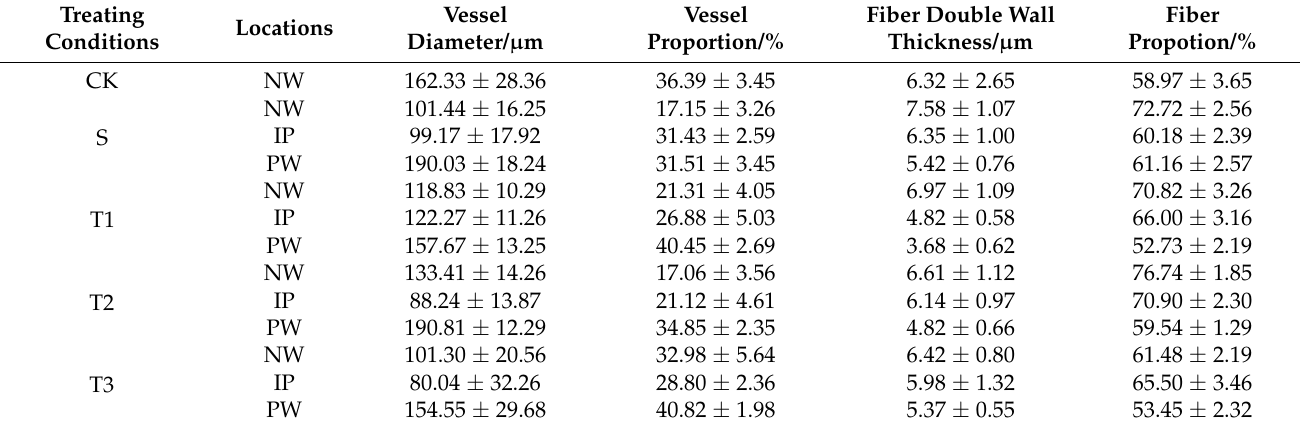
Table 1. Vessel diameter, vessel proportion, fiber proportion and fiber double wall thickness in different positions of poplar under different treatment conditions. The values after the +/ − sign represent the standard deviation: T1, T2 and T3 for the 110,100 mmol/L TEOS modification treatment group, S for the SiO 2 colloidal injection group, CK for the unmodified treatment group, PW for the previously grown wood, IP for the injection point and NW for the newly grown